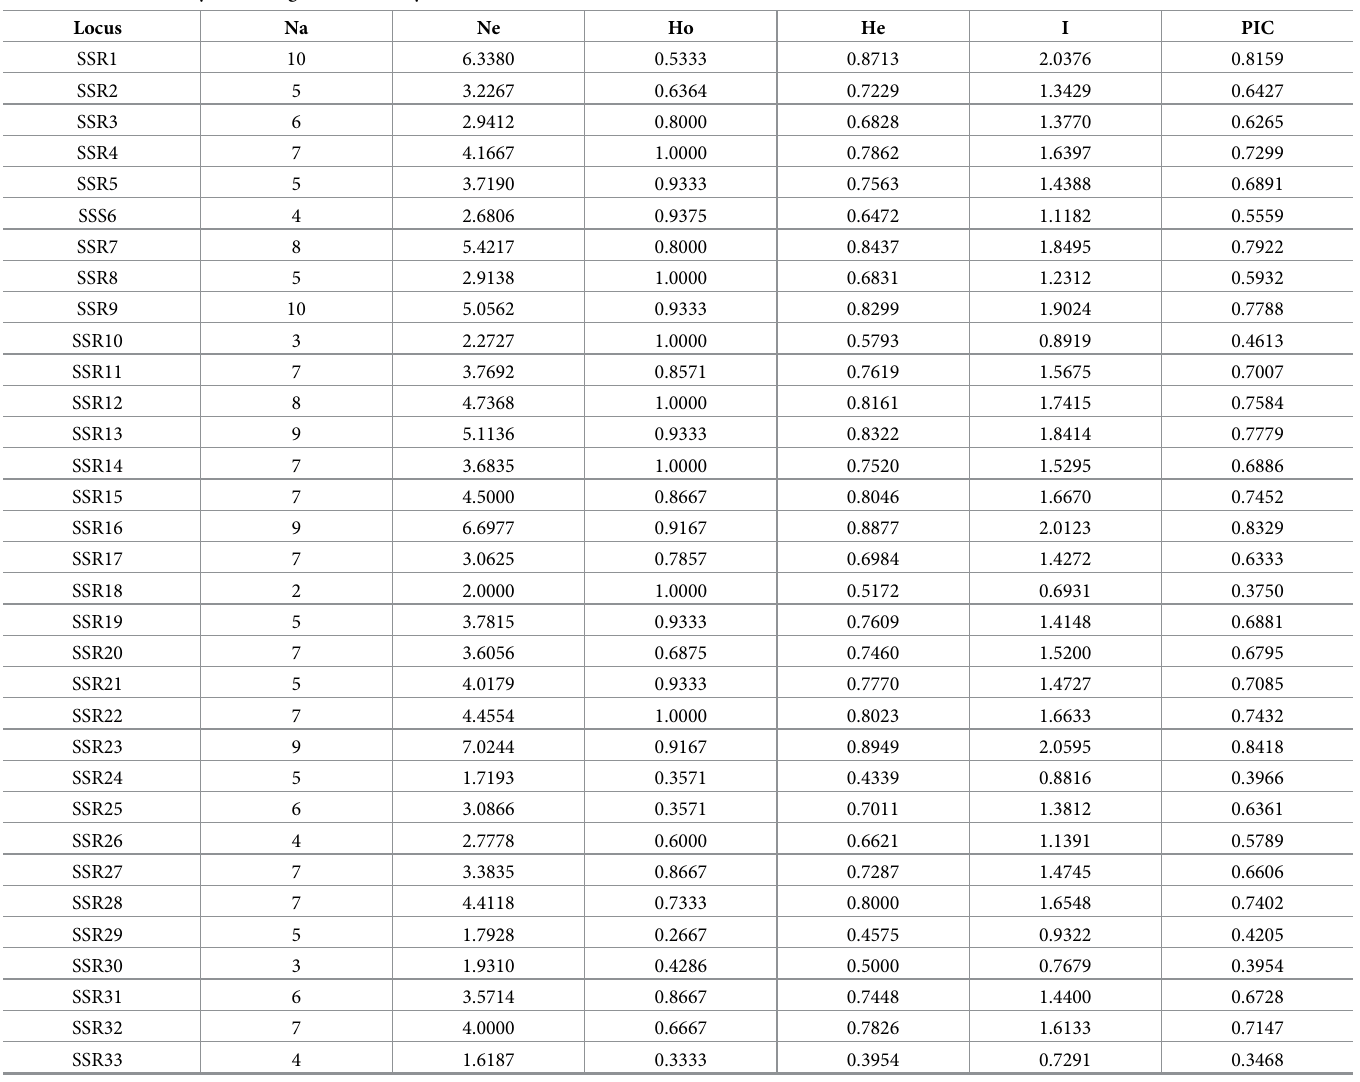
Table 3. Statistical analyses of the genetic diversity of 45 SSR